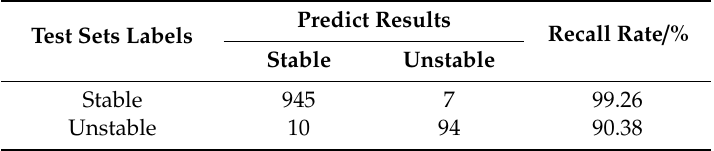
Table 3. Confusion Matrix for classification results of bus voltage amplitude.